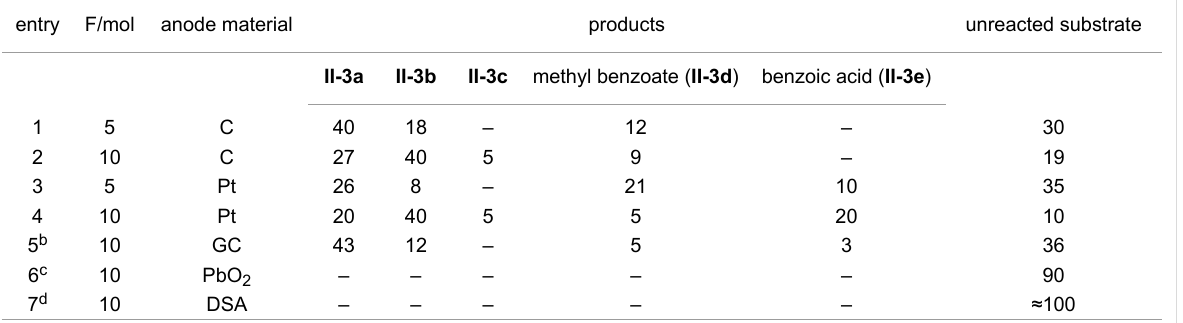
Table 2: The effects of anode material and electricity consumption on the results of anodic oxidation of substrate II-3 in MeOH/LiClO 4a . entry F/mol